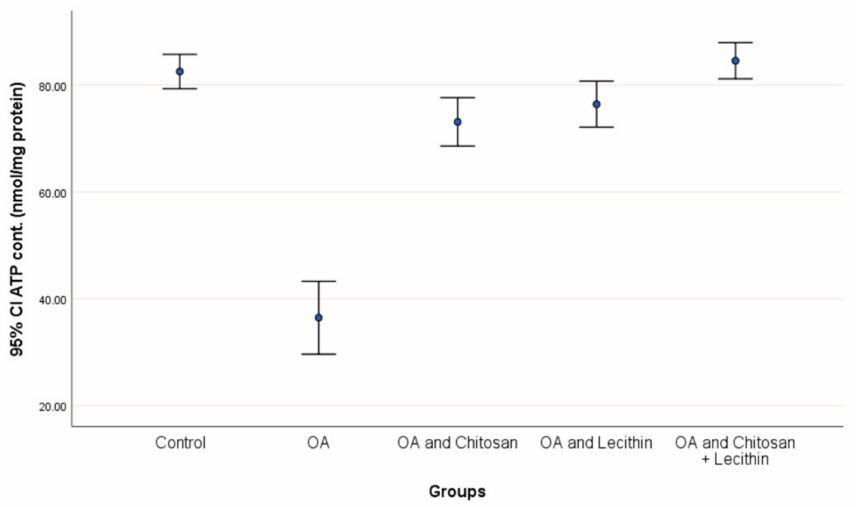
Figure 7. The e ffi cacy of chitosan and lecithin against: ( A ) release of Cytochrome-C and ( B ) the mitochondrial swelling in (OA) model induced by monoiodoacetate (MIA) in male rats. The data presented as mean ± S. E.